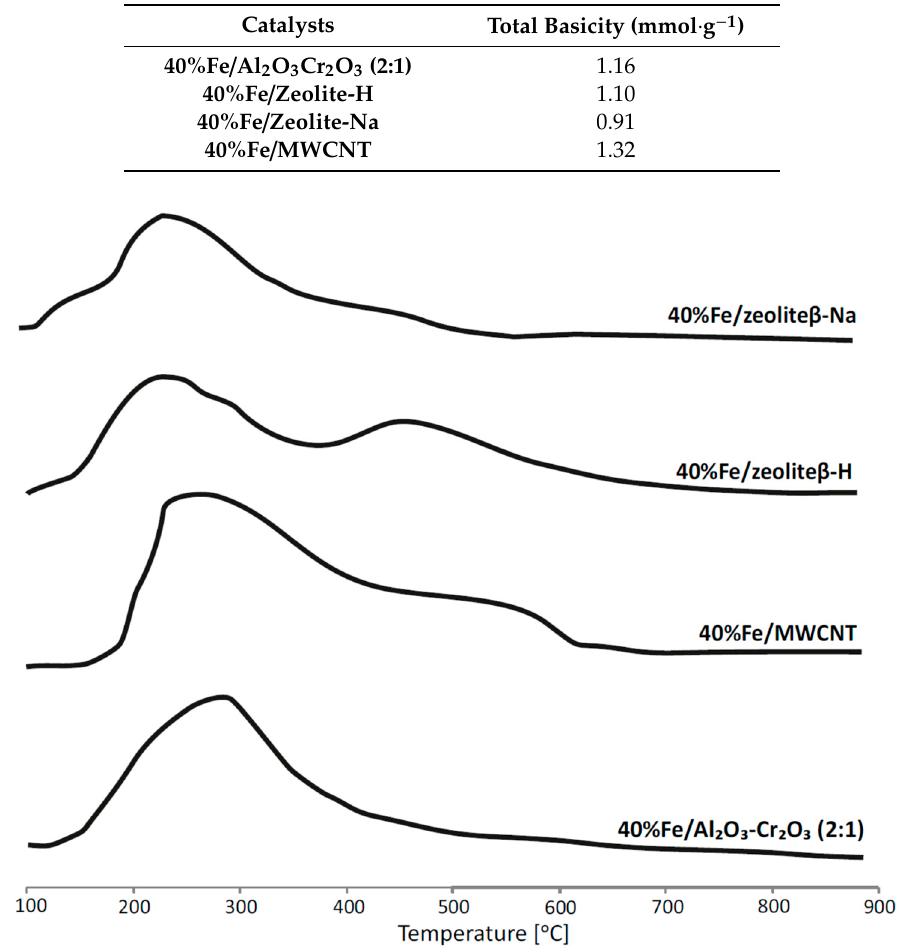
Figure 9. The TPD-CO 2 profiles recorded for reduction at 500 °C in a mixture of 5%H 2 -95%Ar and iron catalysts supported on various carriers.